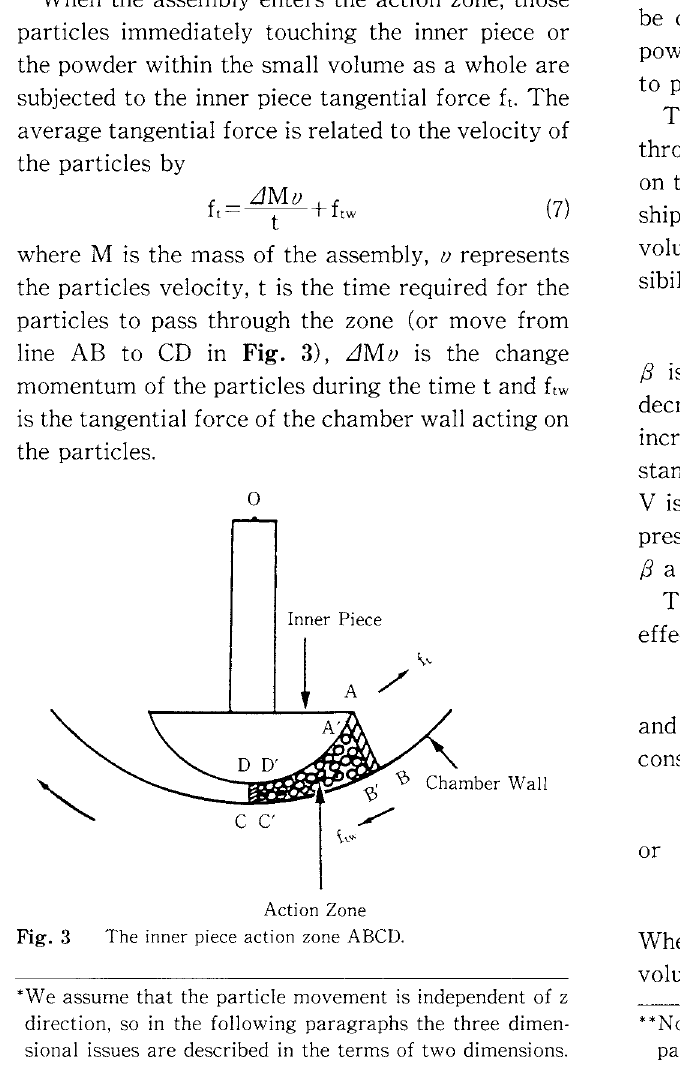
The inner piece action zone